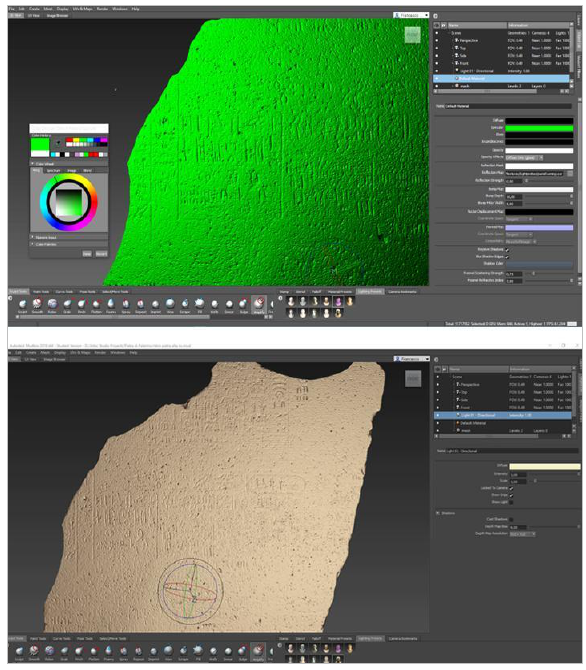
Figure 5: 3D digital model of Palermo Stone; use of sculpting and lighting tools able to guarantee the readability of hieroglyphic writing.